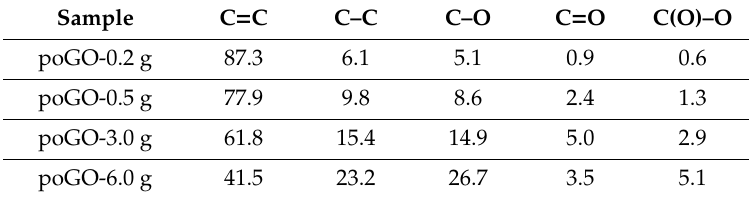
Table 2. Calculated number of individual oxygen functionalities in poGOs measured with XPS in at.%.